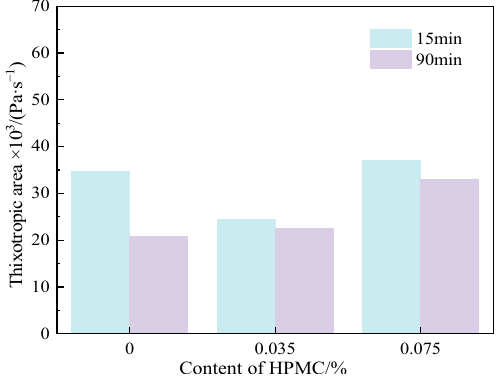
Figure 12. Thixotropic area of C-HPMC pastes.